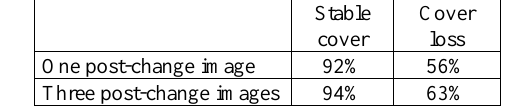
Table 6 . Accuracies of the random forest classifier considering one or three post-change images.